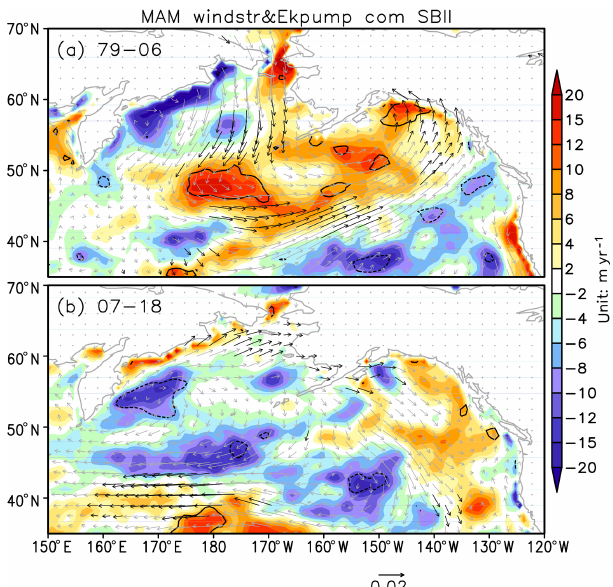
Figure 14. Composites of spring wind stress (vector) and Ekman pumping rate (color shading) based on the SBII high minus low index during the period of 1979–2006 (a) and the period of 2007– 2018 (b) .